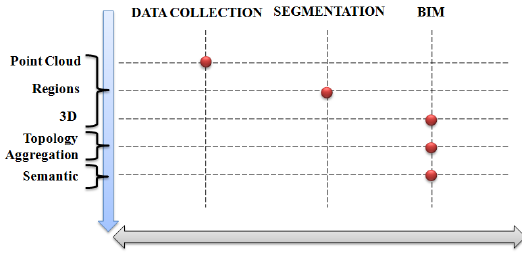
Figure 1: Process of BIM creation composed by complementary and consecutive tasks (collection, segmentation, BIM) in order to get point clouds, regions, 3D representation, relations and attributes